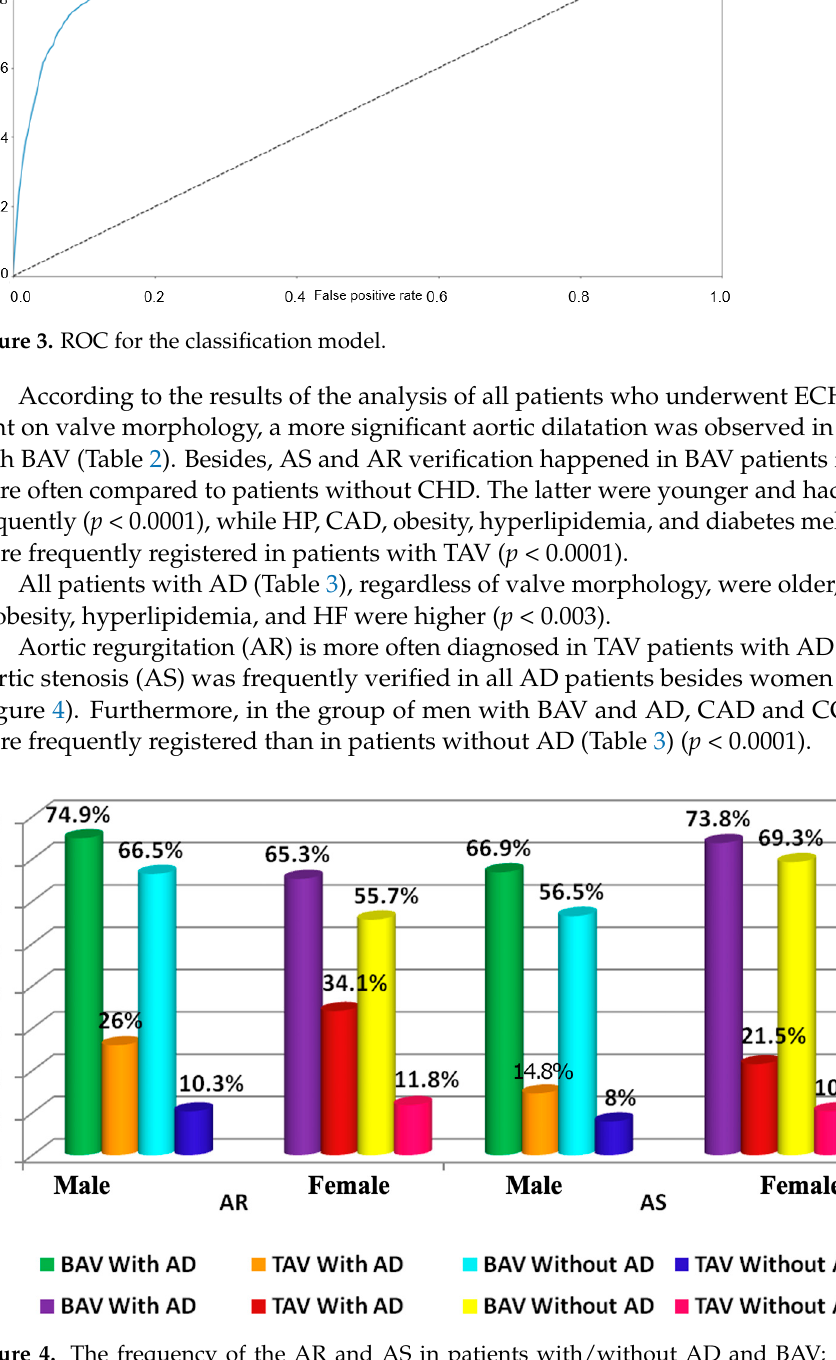
Figure 4. The frequency of the AR and AS in patients with/without AD and BAV; AR—aortic regurgitation; AS—aortic stenosis.